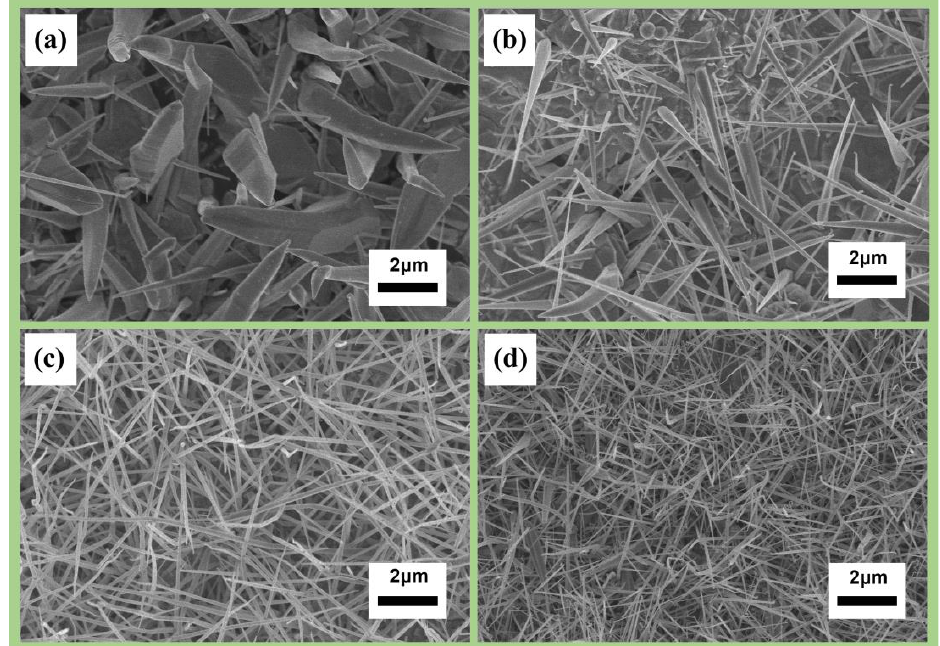
Figure 2. Morphologies of indium oxide nanowire synthesis at different temperatures and deposition positions: ( a ) 875 °C at 1 cm; ( b ) 810 °C at 3 cm; ( c ) 710 °C at 5 cm; ( d ) 650 °C at 7 cm.